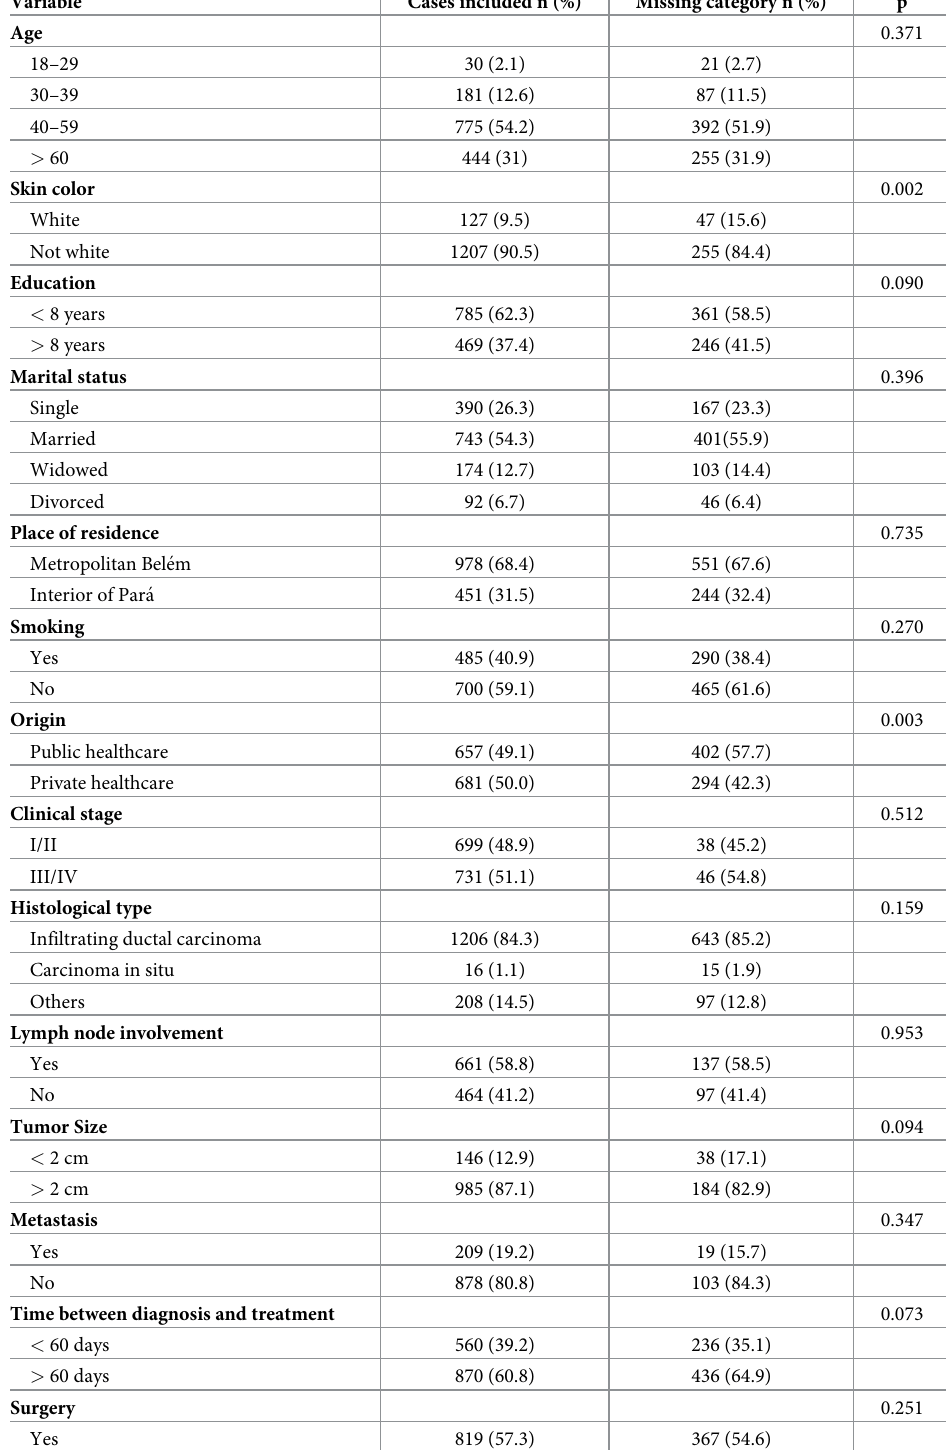
Table 1. Comparison between sociodemographic and clinical variables of the included and excluded population in this